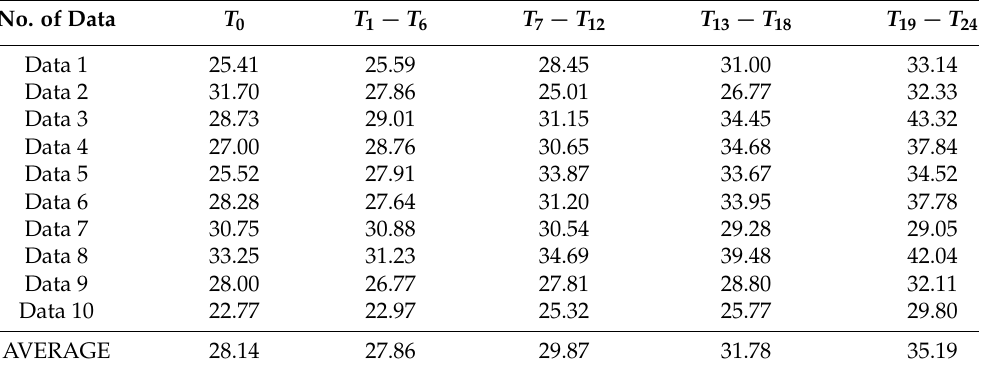
Table 4. The MAE with only LSTM AutoEncoder as the predictor for all 10 times. The values in the table are the MAE of AQI